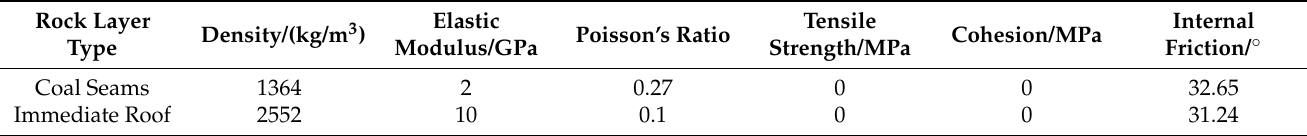
Figure 4. Numerical model. Table 1. Assignment of coal and rock mechanics parameters.